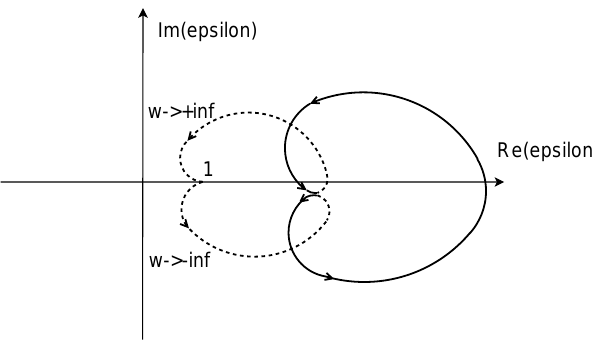
Fig. 7. Representative drawing of the plasma dispersion curve C (cid:15) : ion ( | ω/k | < 3km/s) (solid) and electron ( | ω/k | > 3km/s) (dashed) features. The contour plots in Fig. 6 show only the ion